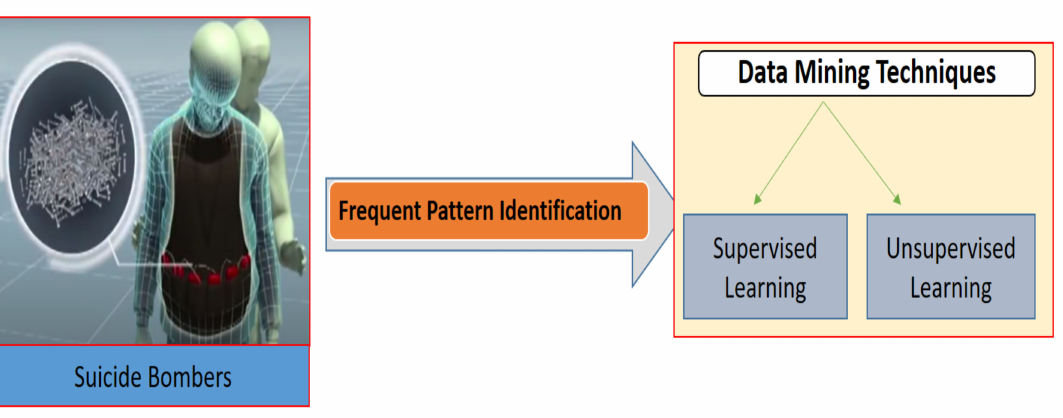
Figure 1. Suicide bombers’ frequent pattern identification